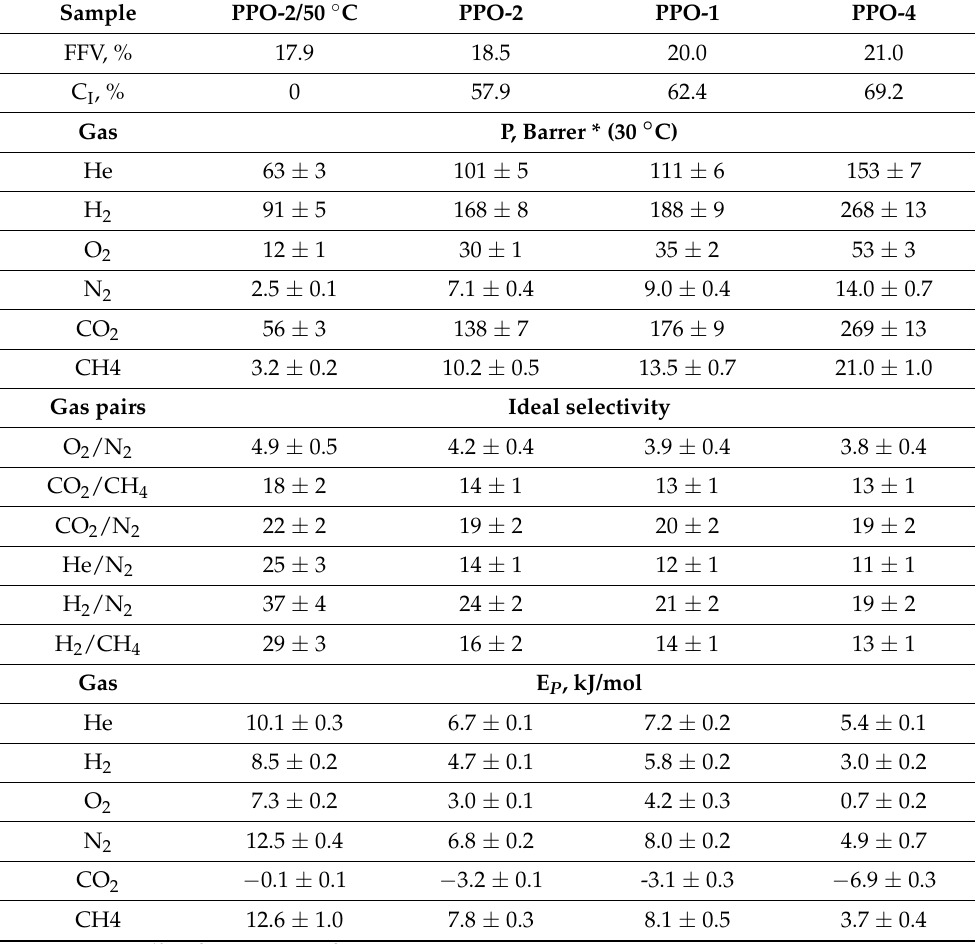
Table 4. Gas permeability coefficients, gas separation selectivities, and activation energies of perme- ation of the studied PPO